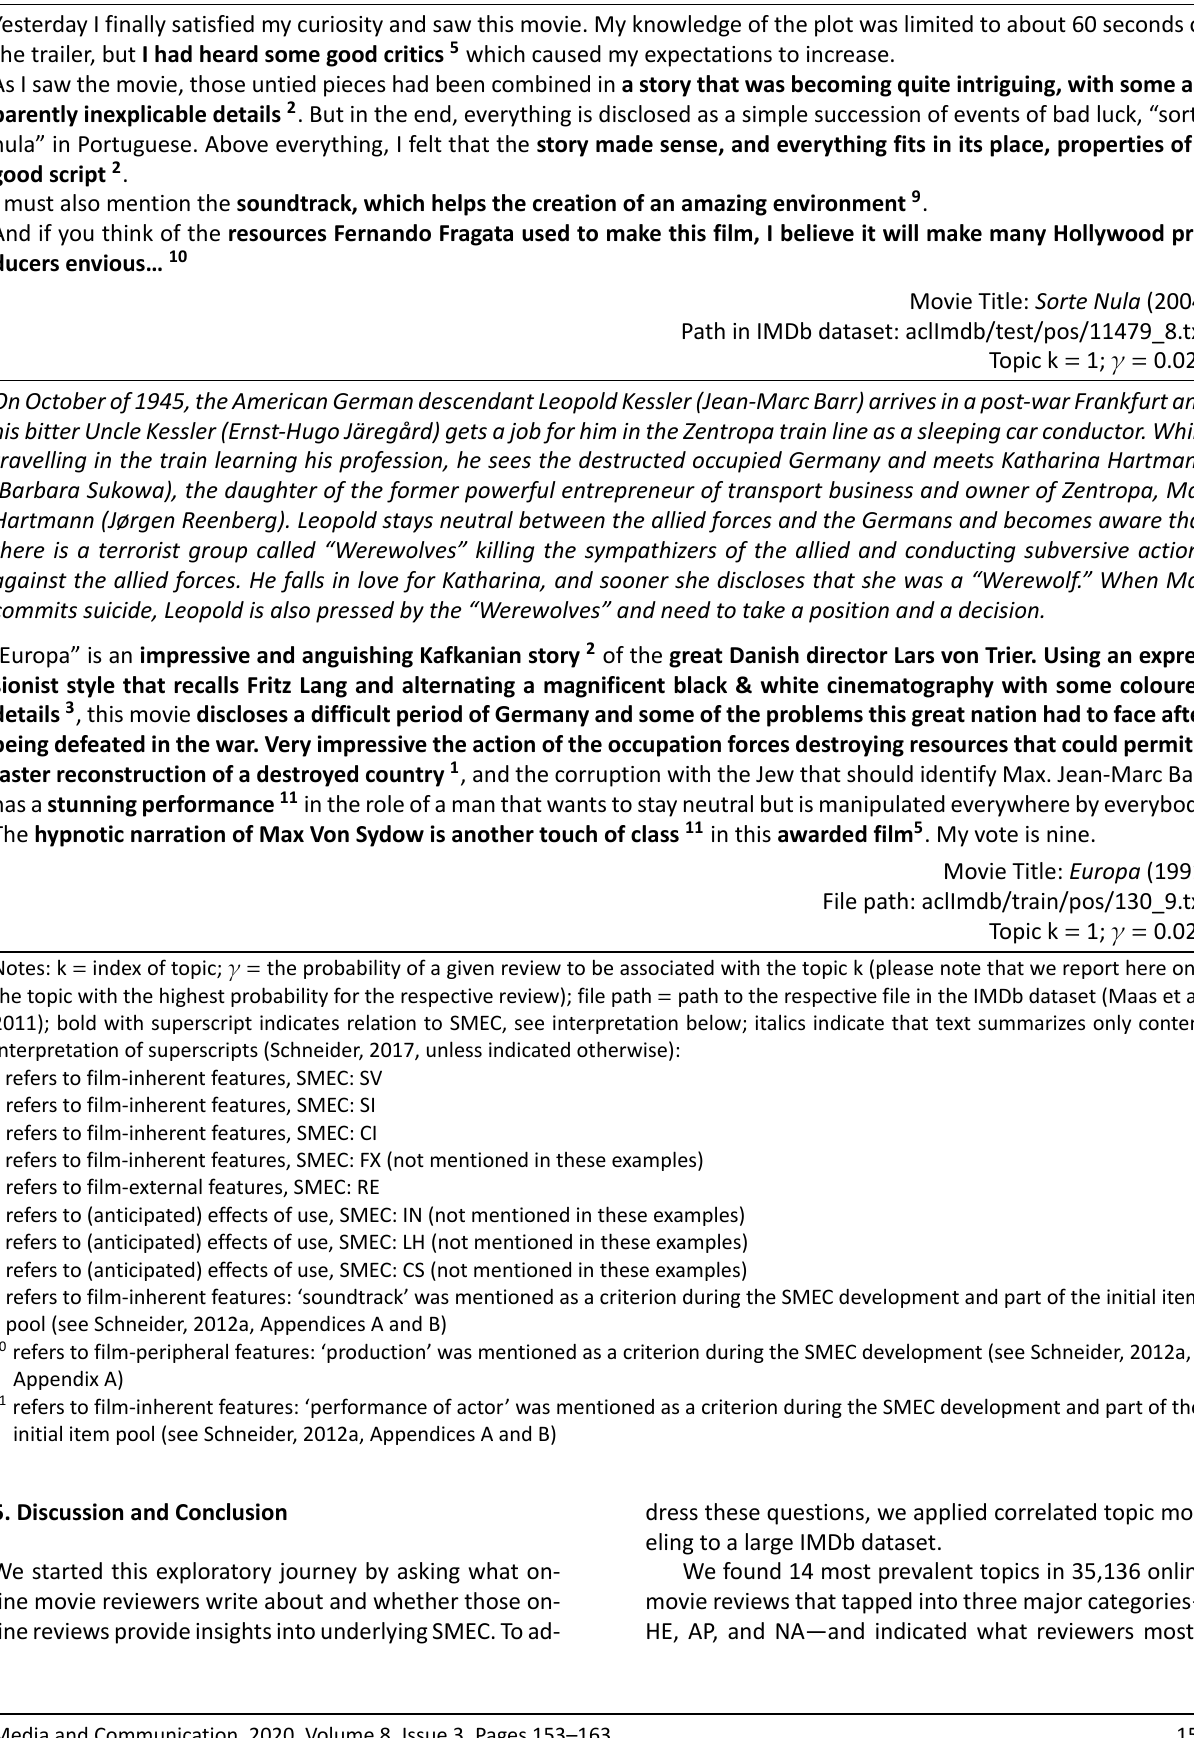
Table 2. Two examples of randomly selected reviews with 𝛾 ≥ 0.02 for each topic (k).